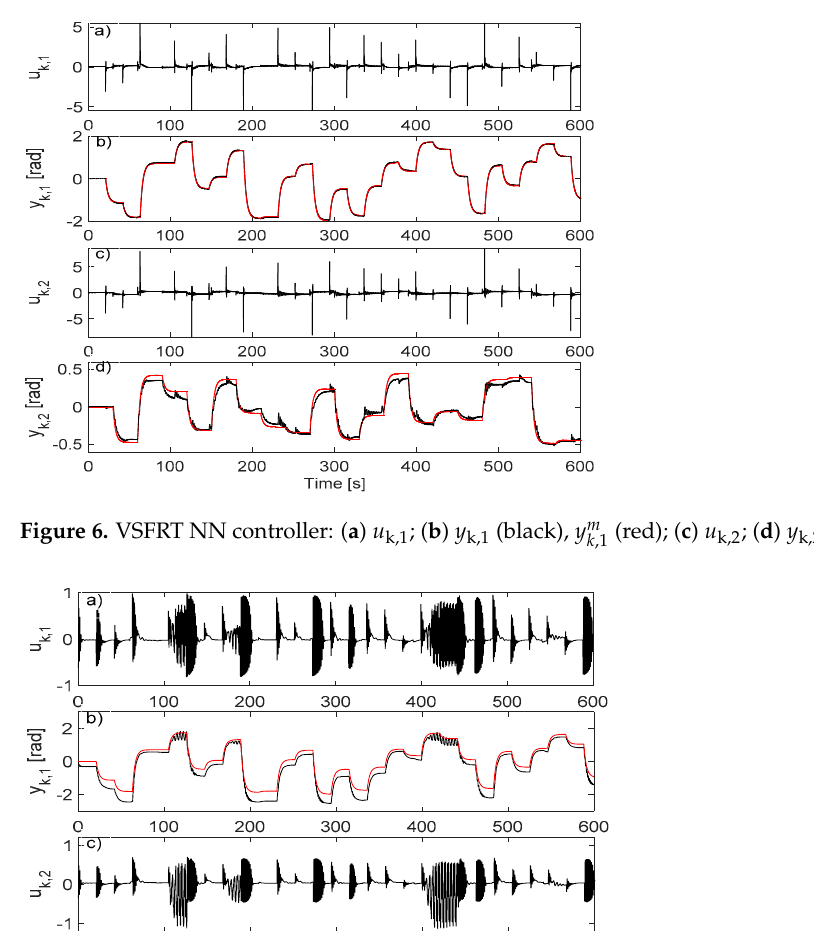
Figure 7. AI-VIRL NN controller: ( a ) u k,1 ; ( b ) y k,1 (black), y m